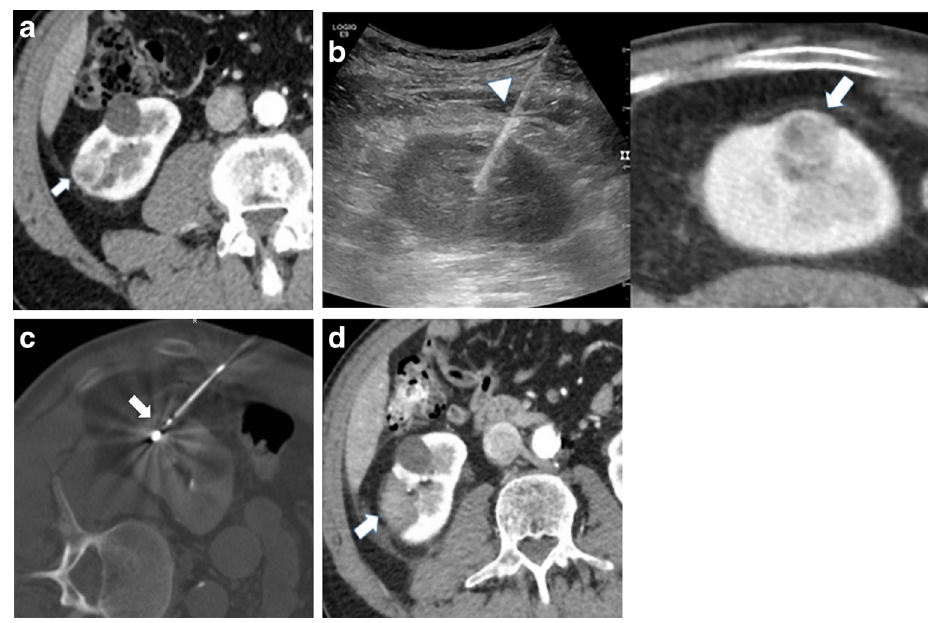
Fig. 2 Microwave ablation of a left posterior renal cell carcinoma close to the colon with hydrodissection. a Contrast enhanced CT demonstrating a left posterior renal cell carcinoma ( white arrow ) to be treated with percutaneous thermal ablation. b Contrast enhanced CT performed the day of the procedure. To achieve a safe path to the tumour the patient is placed in prone position with external compression. In this position, the colon ( asterisks ) appears to be close to the tumour to be treated ( white arrow ). c fusion of contrast enhanced CT and real-time US allowed for the identification of the tumour to be treated with US ( white arrow = tu- mour; asterisks = colon ). d under US guidance a small spinal needle